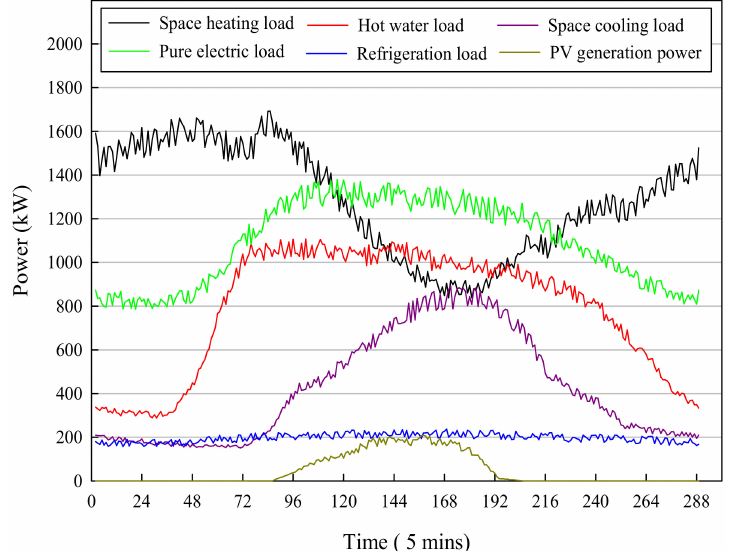
Figure 8. The real-time fluctuation curve of the cooling, heating and electrical load and renewable energy power output in the integrated energy system.